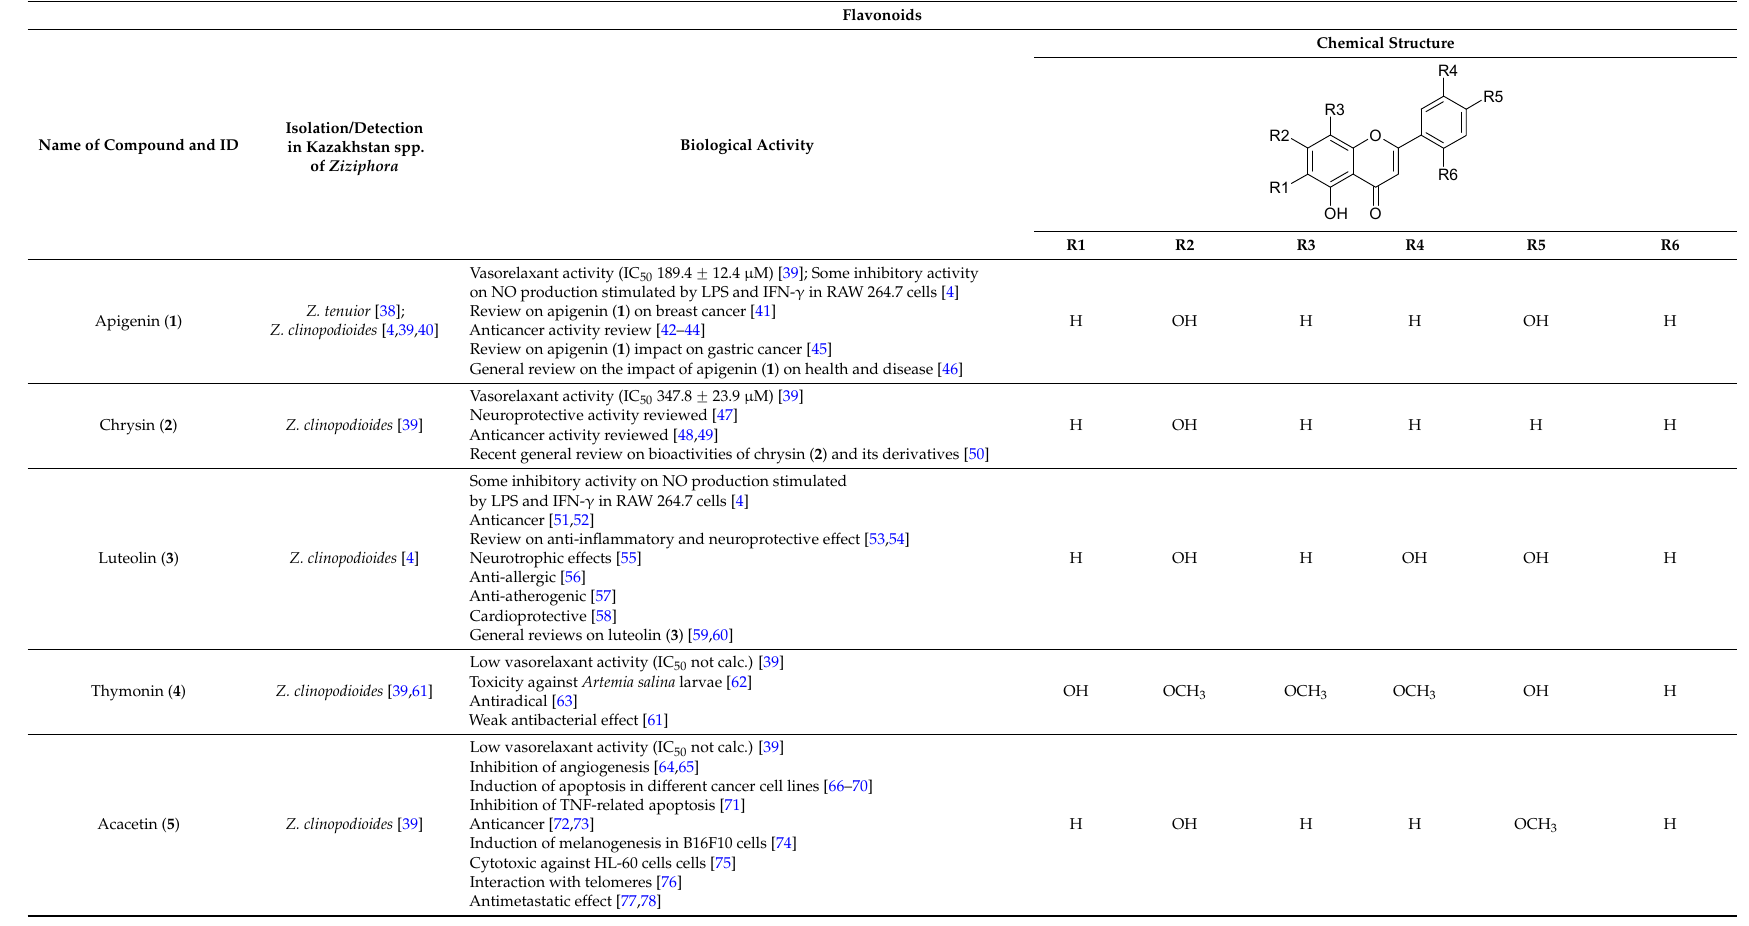
Table 1. Phenolic substances isolated from Kazakhstan Ziziphora species. (N.f.—not found).